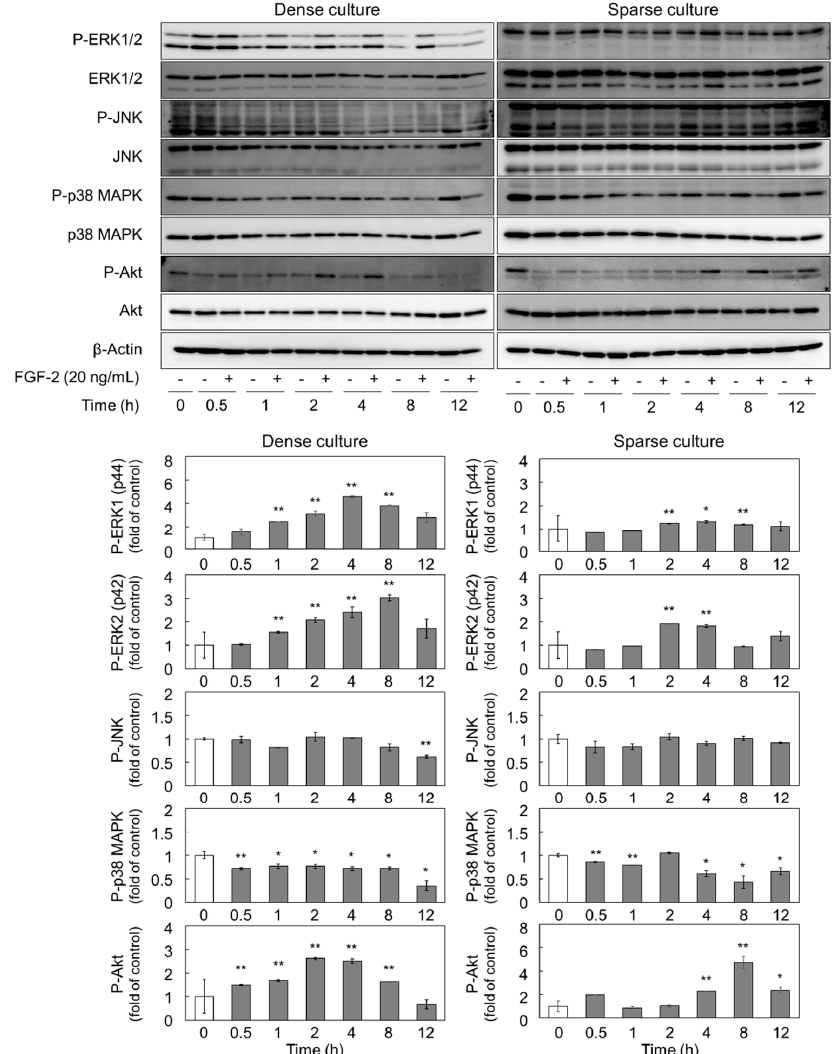
Figure 3. Effects of FGF-2 on the activation of ERK1/2, JNK, p38 MAPK, and Akt in dense and sparse cultures of vascular endothelial cells. Dense and sparse cultures of vascular endothelial cells were treated with or without 20 ng/mL FGF-2 at 37 °C for 0.5, 1, 2, 4, 8, and 12 h. The expression of P-ERK1/2, ERK1/2, P-JNK, JNK, P-p38 MAPK, p38 MAPK, P-Akt, Akt, and β -Actin proteins was assessed by western blotting. The bar graph shows the expression ratio of the phosphorylated MAPKs and phosphorylated Akt in the FGF-2-treated group compared with that in the control group at each time point. The values in the bar graphs indicate the means ± S.E. of three samples of the experiments. Significantly di ff erent from the corresponding control, * p < 0.05 and ** p <